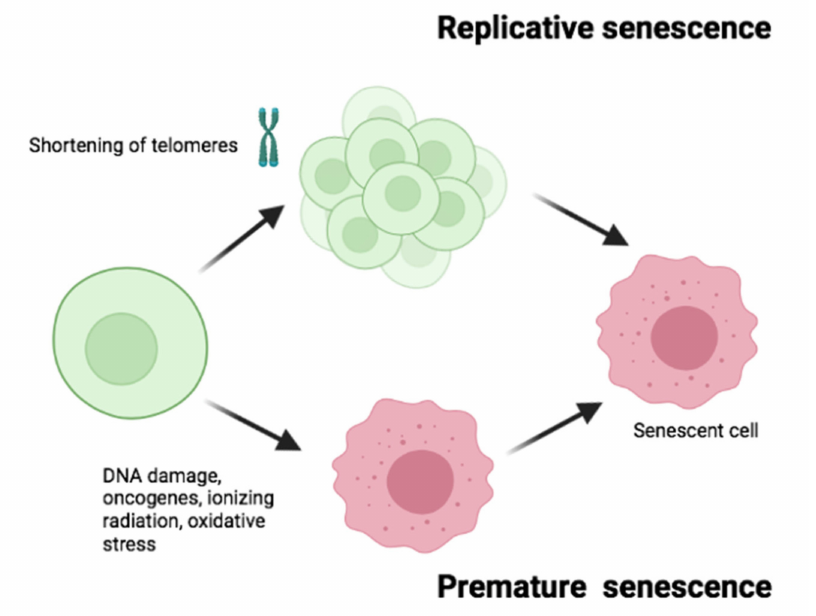
Figure 2. Types of senescence. Cellular senescence may be triggered by two different mechanisms: Replicative senescence and premature senescence. Replicative senescence refers to the decrease in proliferation due to shortening of telomeres as a consequence of multiple cell division. While premature senescence occurs in response to various stress stimuli, such as DNA damage, oncogenes, ionizing radiation, or oxidative